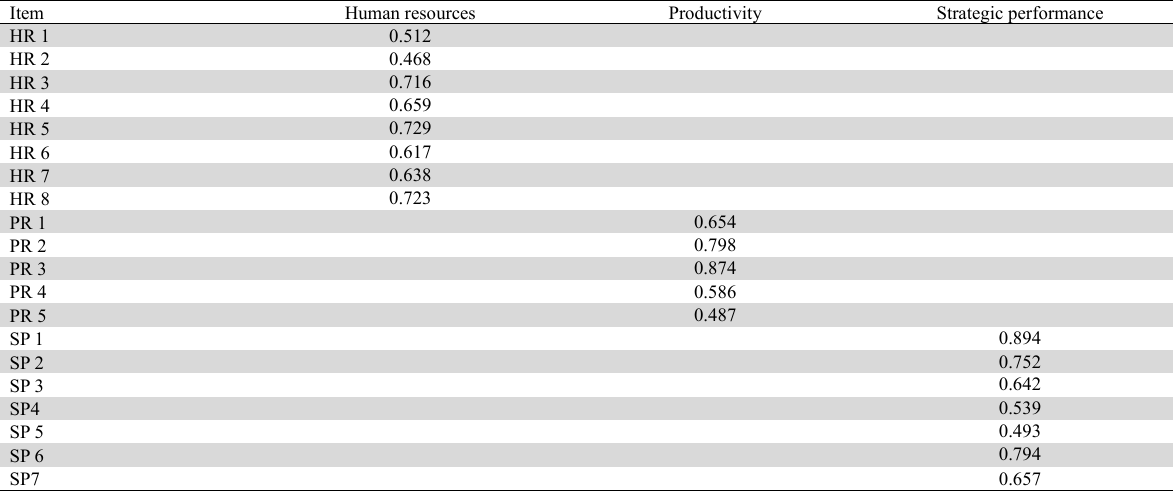
EFA of the measurement